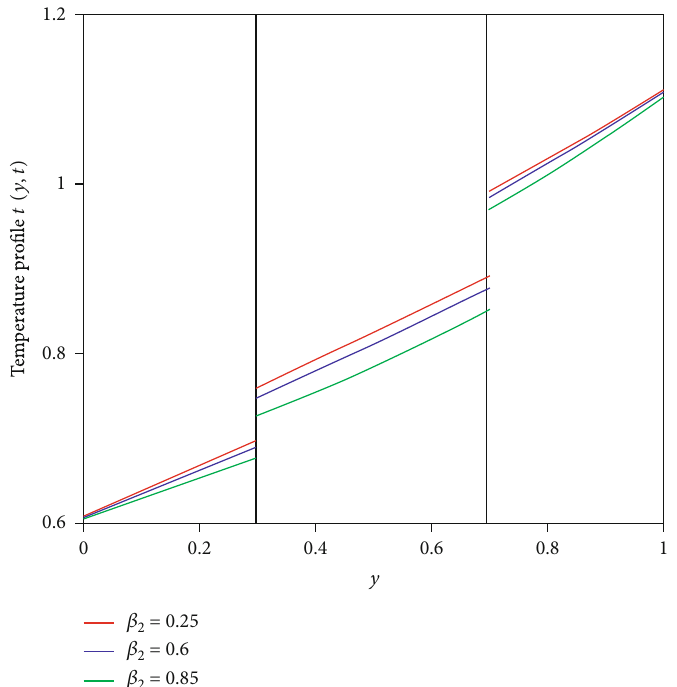
Figure 3: Temperature pro fi les T values of β 2